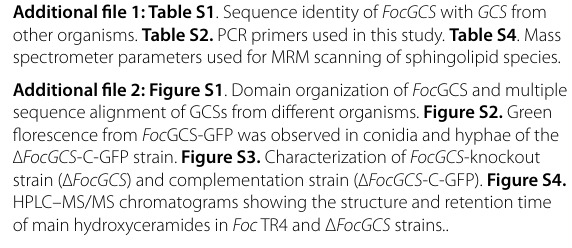
Additional file 3: Table S3 . Detailed information of differentially expressed